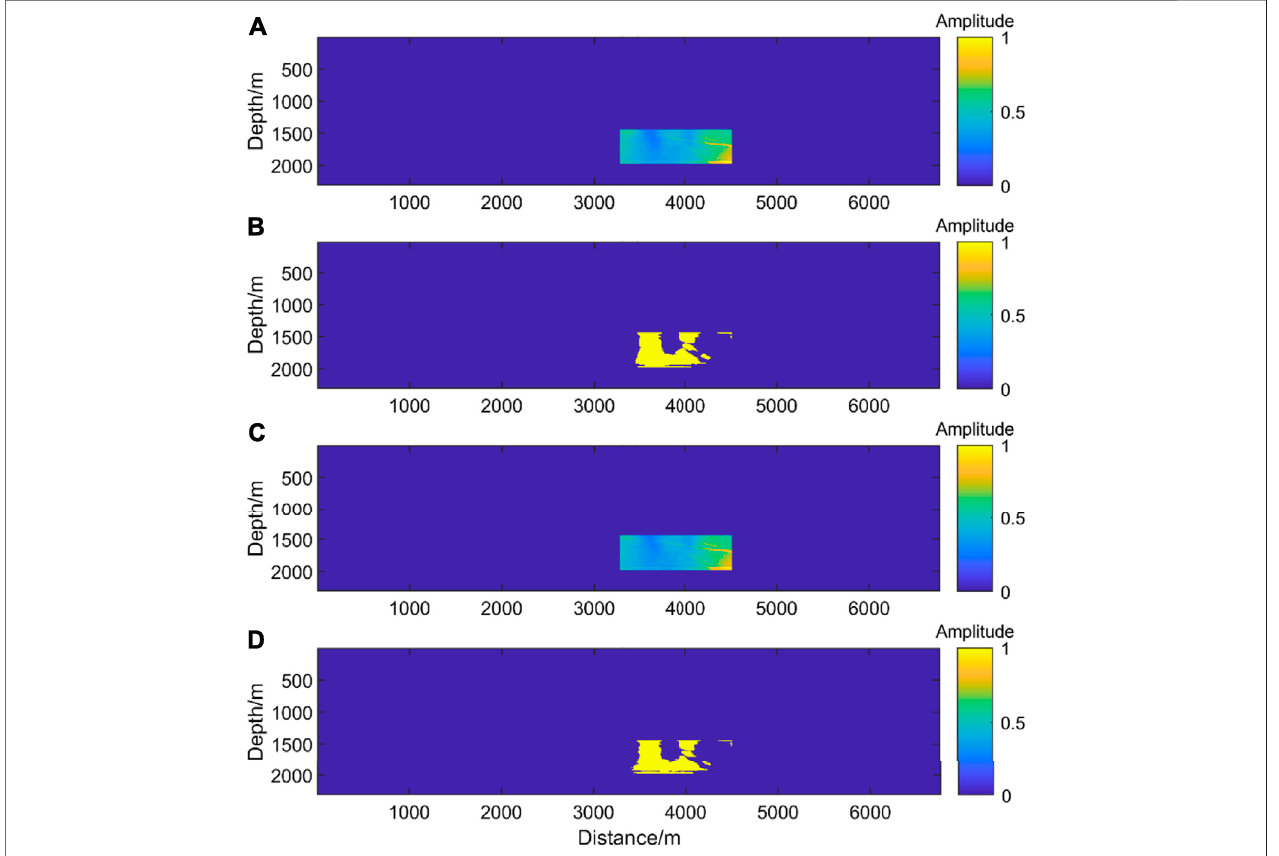
Frontiers in Earth Science |